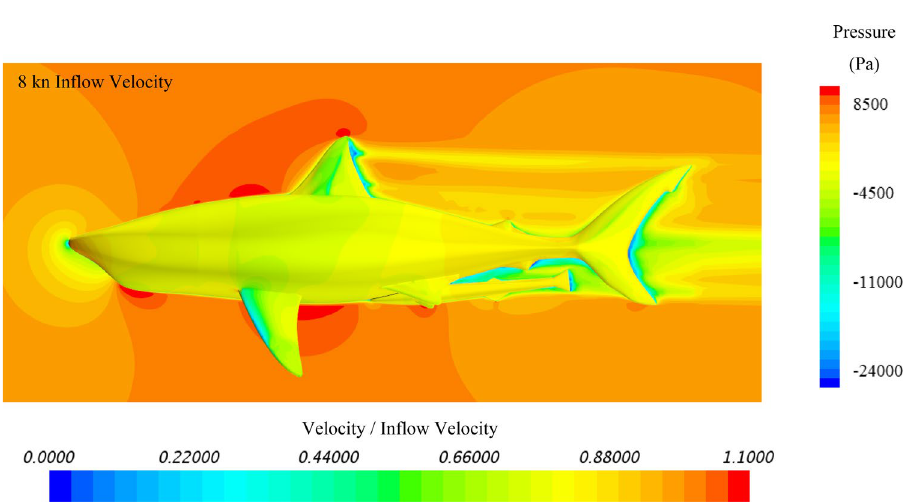
Figure 23. Velocity and pressure contours of the remora attached to the belly of the shark (Pressure contour displayed on the surface of model, and velocity contours displayed on the section plane) (Created using Simcenter STAR-CCM + 2019.2.1 Build